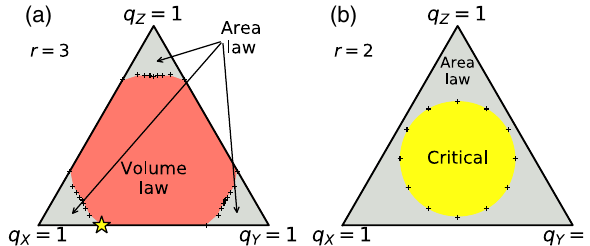
FIG. 4. Phase diagrams of factorizable ensembles with q ¼ ð 0 ; q ; q ; q (Pauli strings without identities) for ranges X Y Z Þ r ¼ 3 (a) and r ¼ 2 (b). The starred point in (a) is the phase transition studied in Fig. 5. The þ symbols are numerical estimates of the phase boundary, obtained from finite-size crossings of the tripartite mutual information I 3 [Eq. (8)] in (a) and from the finite-size scaling of half-cut entanglement entropy in (b). Data are obtained from stabilizer numerical simulations of systems of up to L ¼ 512 qubits, averaged over between 10 2 and 10 4 realizations depending on L . Only the > q > q wedge q is simulated, with the rest of the phase X Y Z diagram obtained by